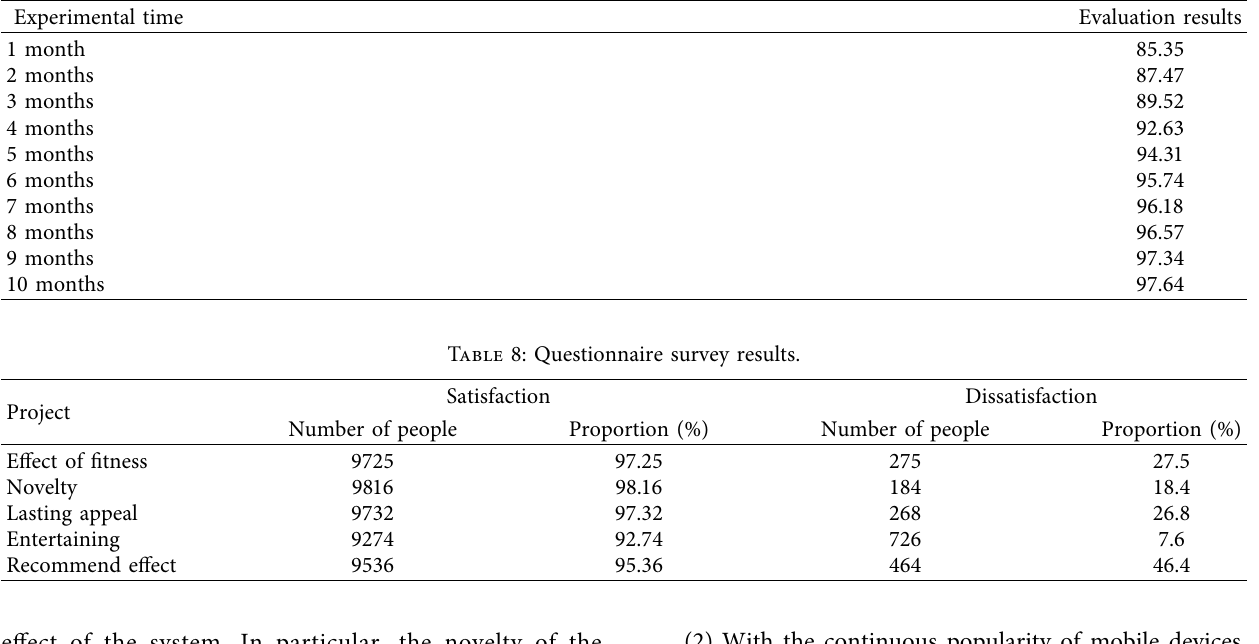
Table 7: User evaluation results.